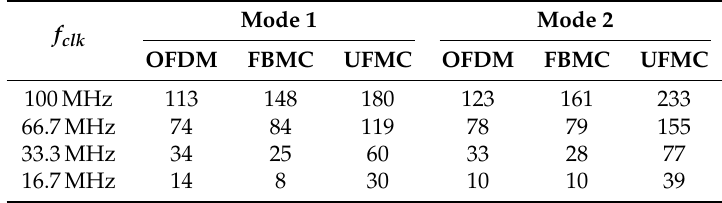
Table 6. Dynamic power consumption estimates for the six implemented baseband modulator cores (in mW). Device: xc7z020; analysis tool: Vivado 2015.2; post-implementation power analysis with a high confidence level; node activity derived from post-implementation simulation.